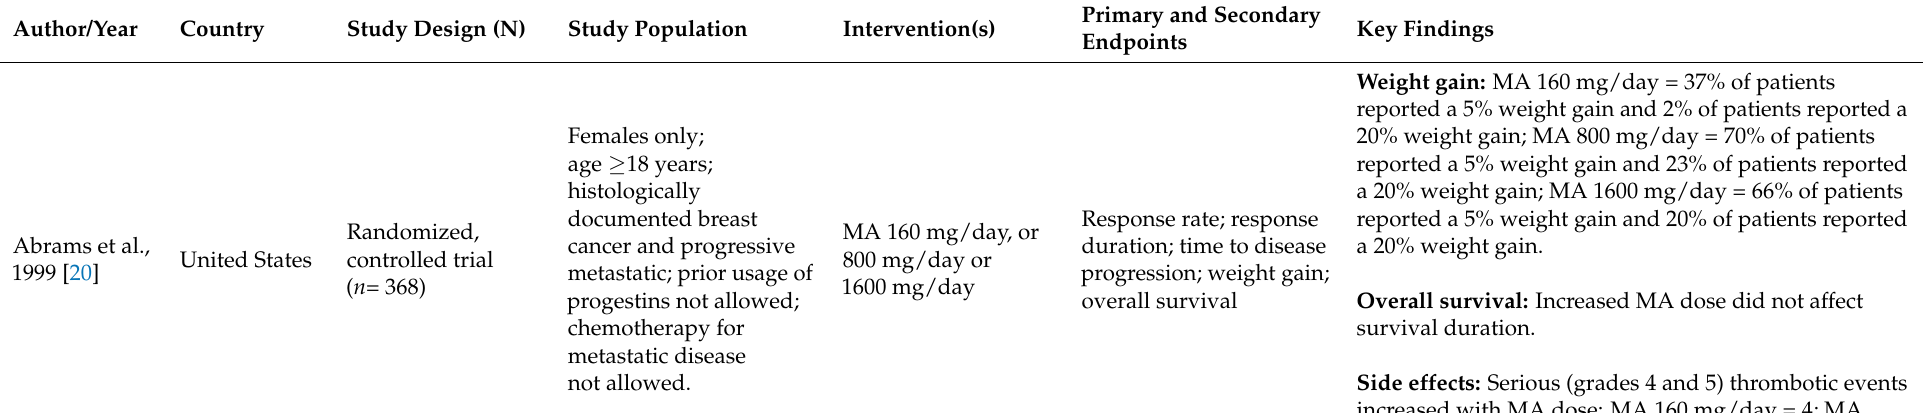
Table 1. The characteristics and findings of the studies reviewed (arranged in alphabetical order according to the first author’s last